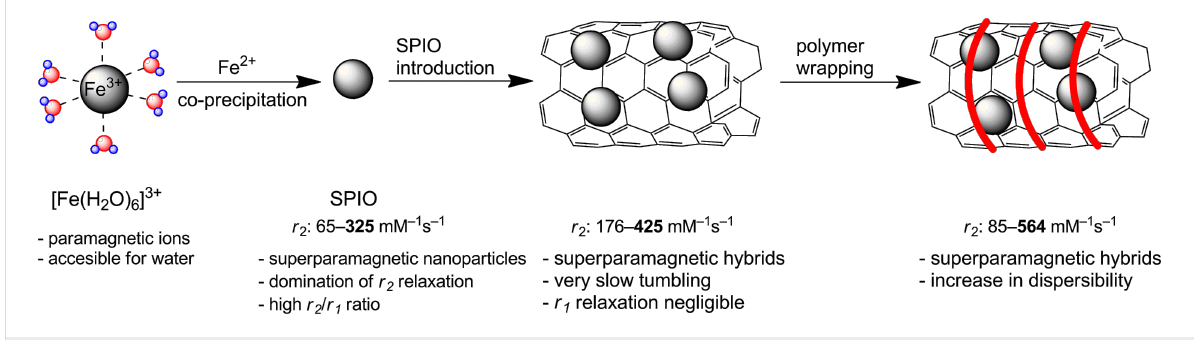
Figure 5: Relaxivity evolution by transformations of iron complexes to SPIOs and forming MWCNT hybrids. The relaxivities in bold face type highlight the trend of an increasing r 2 value.